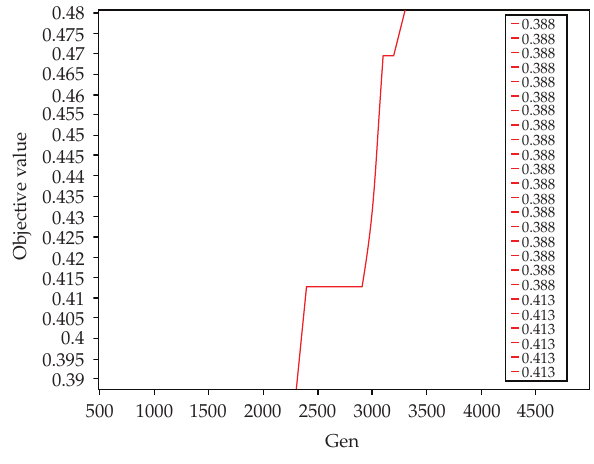
Figure 1: The results by